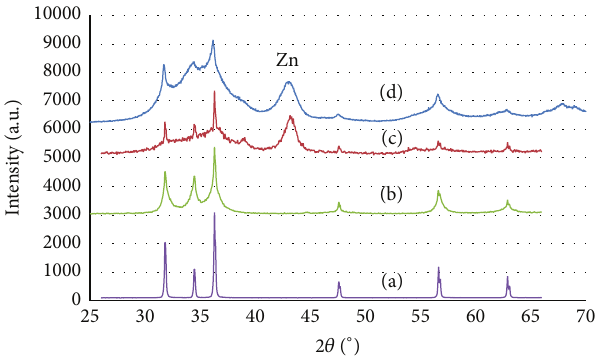
Figure 1: XRD pattern of (a) ZnO submicron powder, (b) ZnO nanopowder (Po 2 = 45 Pa), (c) NP ZnO-Zn, and (d) NP ZnO-Zn-Fe ( 𝑥 Fe = 0.619 wt